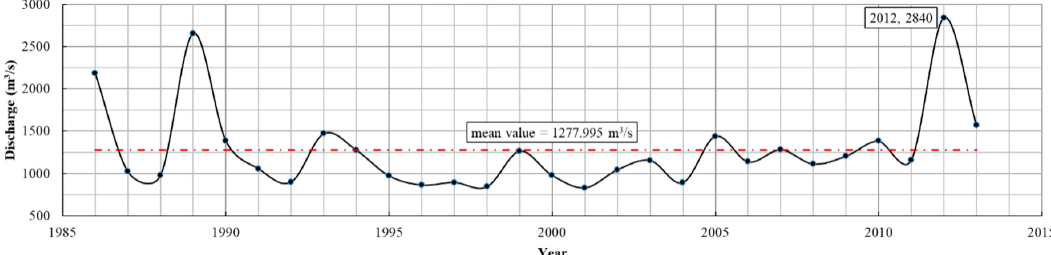
Figure 10. Actual measured maximum monthly mean discharge levels of the Xiaheyan Hydrological Station in the NRYR over time.